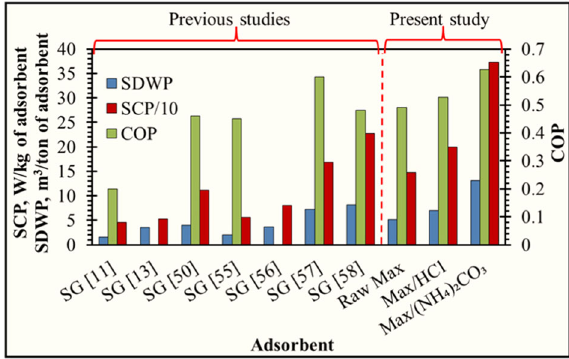
Fig. 8 Comparing the raw and modi fi ed Max-based ACD cycle performance with previous studies 11,15,53 – 57 at 85 °C De-T. The Max/(NH 4 ) 2 CO 3 performance is about double SG performance for dual cooling and desalination